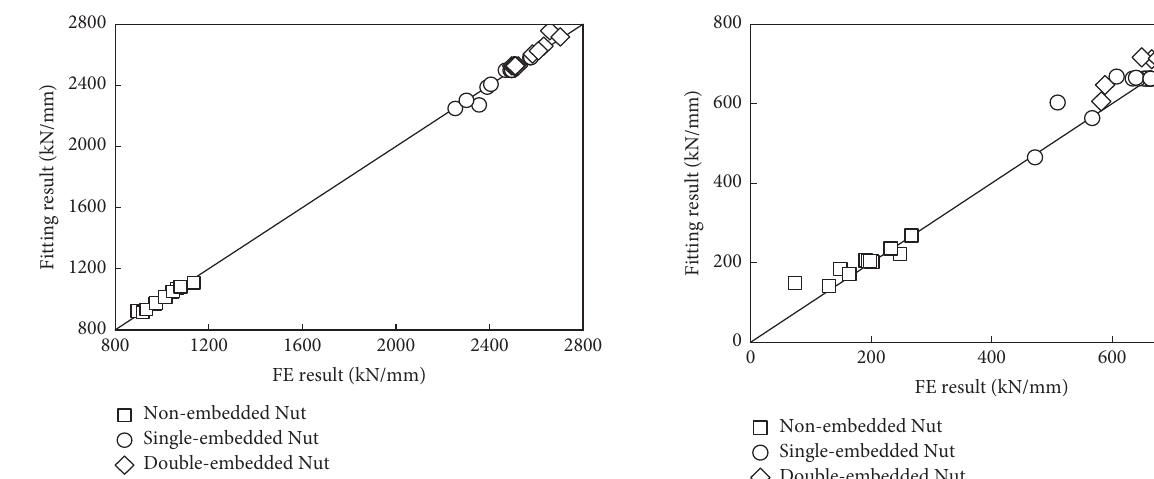
Figure 7: Comparisons of shear stiffness between the FE results and fitting results.